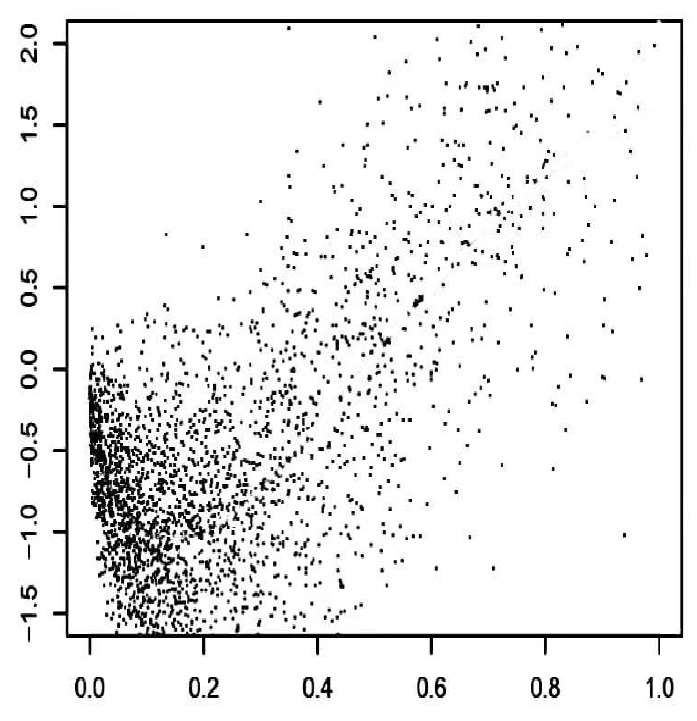
Figure 1. Raw data in the NGHS